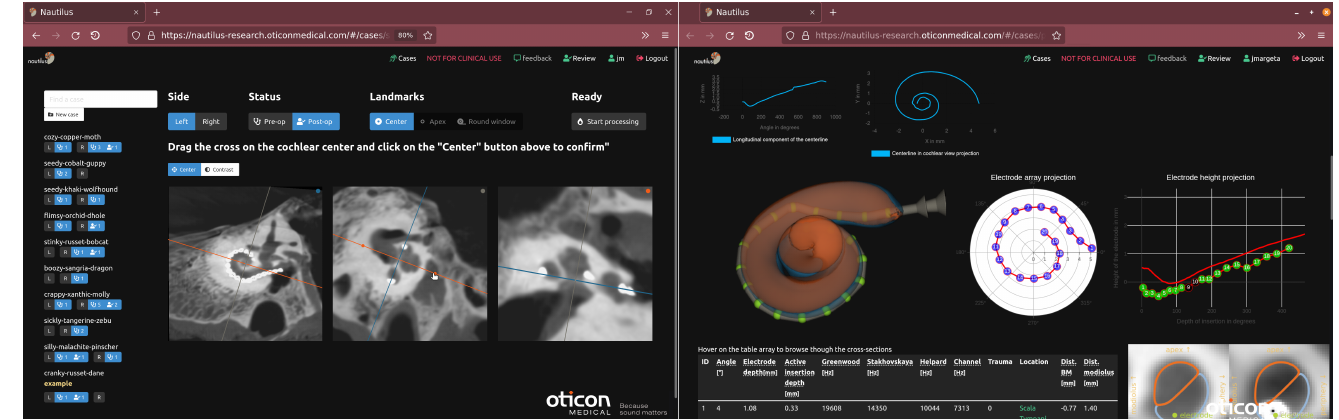
Figure 1. Nautilus offers a comprehensive set of research tools for pre- and post-operative cochlear image analysis for CI implantation and interactive visualization via a web browser. A number of metrics and additional outputs are generated by the pipeline and are made available for data export (e.g., spreadsheet of metrics for all cochleae in a user’s collection or STL models of the cochlear meshes) for further data analysis and applications (e.g., simulation or 3D printing, novel electrode array